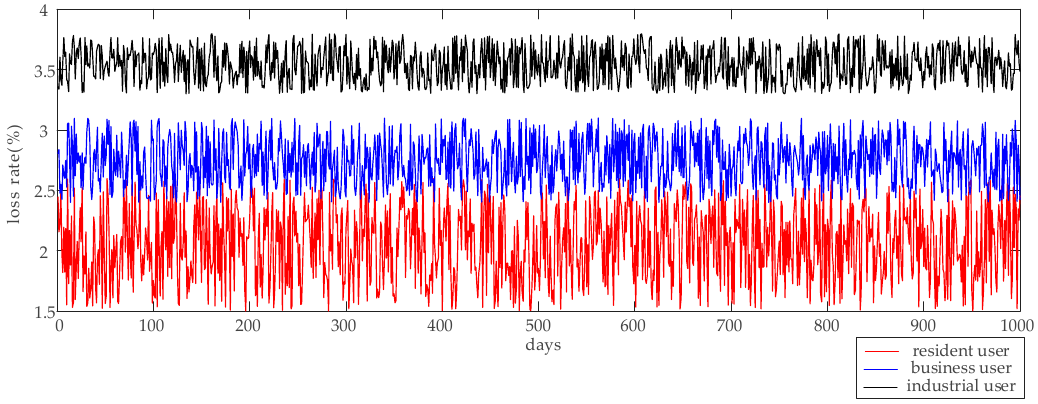
Figure 7. The estimated line loss rate results.